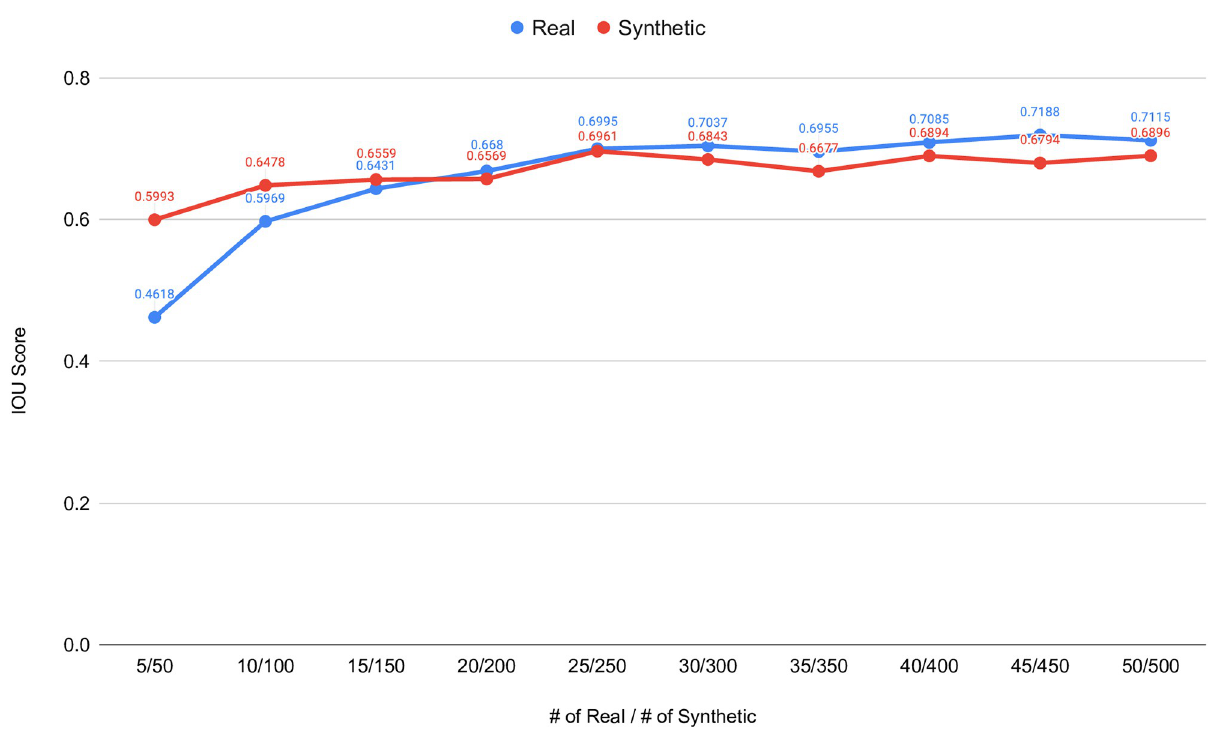
Fig 11. Real versus fake performance comparison with small training datasets. Fake datasets are generated with the style transfer method using content : style ratio of 1: 1,